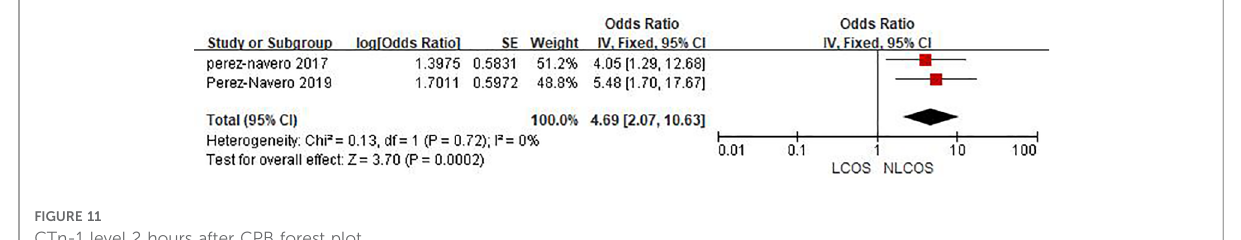
FIGURE 11 CTn-1 level 2 hours after CPB forest plot.